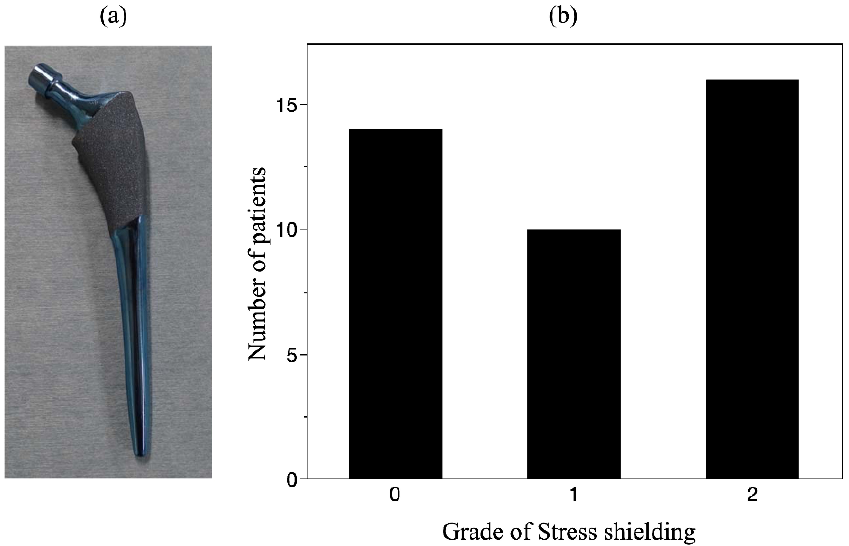
Figure 1. Clinical application of TiNbSn femoral stem: ( a ): Photograph of TiNbSn femoral stem, ( b ): Mid-term results at 3 years after surgeries show the incidence of only mild stress shielding. Engh’s stress shielding classification is grade 0 to 4, with 5 levels. No serious stress sealing of grade 3 or higher was observed.